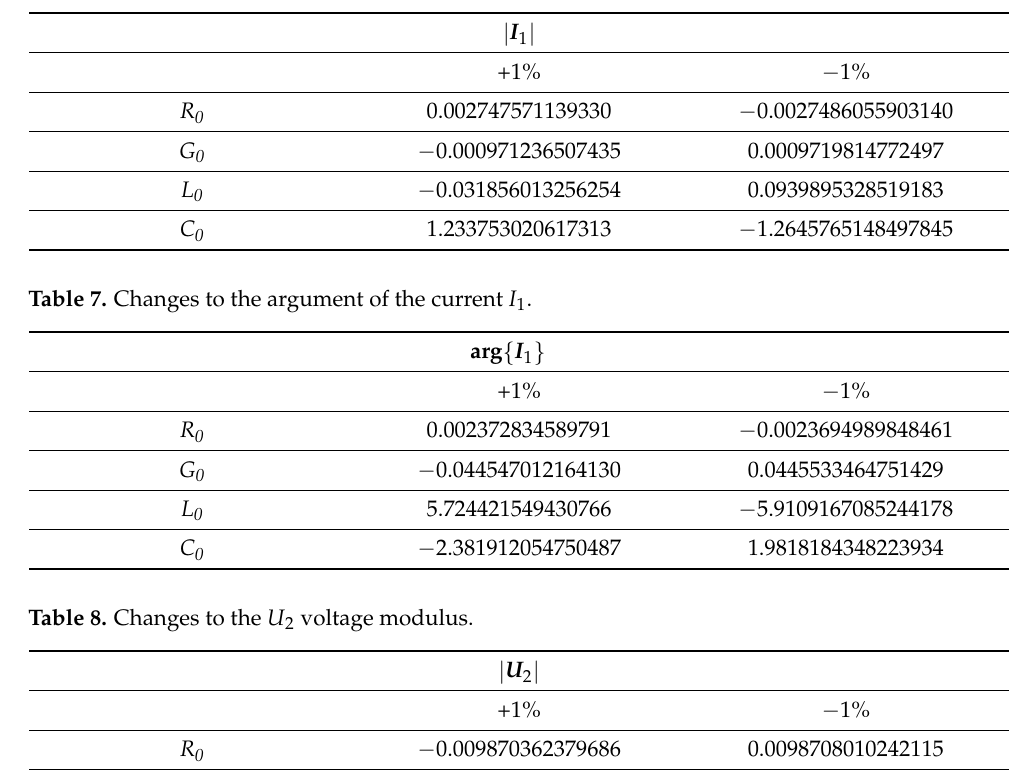
Table 6. Changes to the I 1 current modulus.